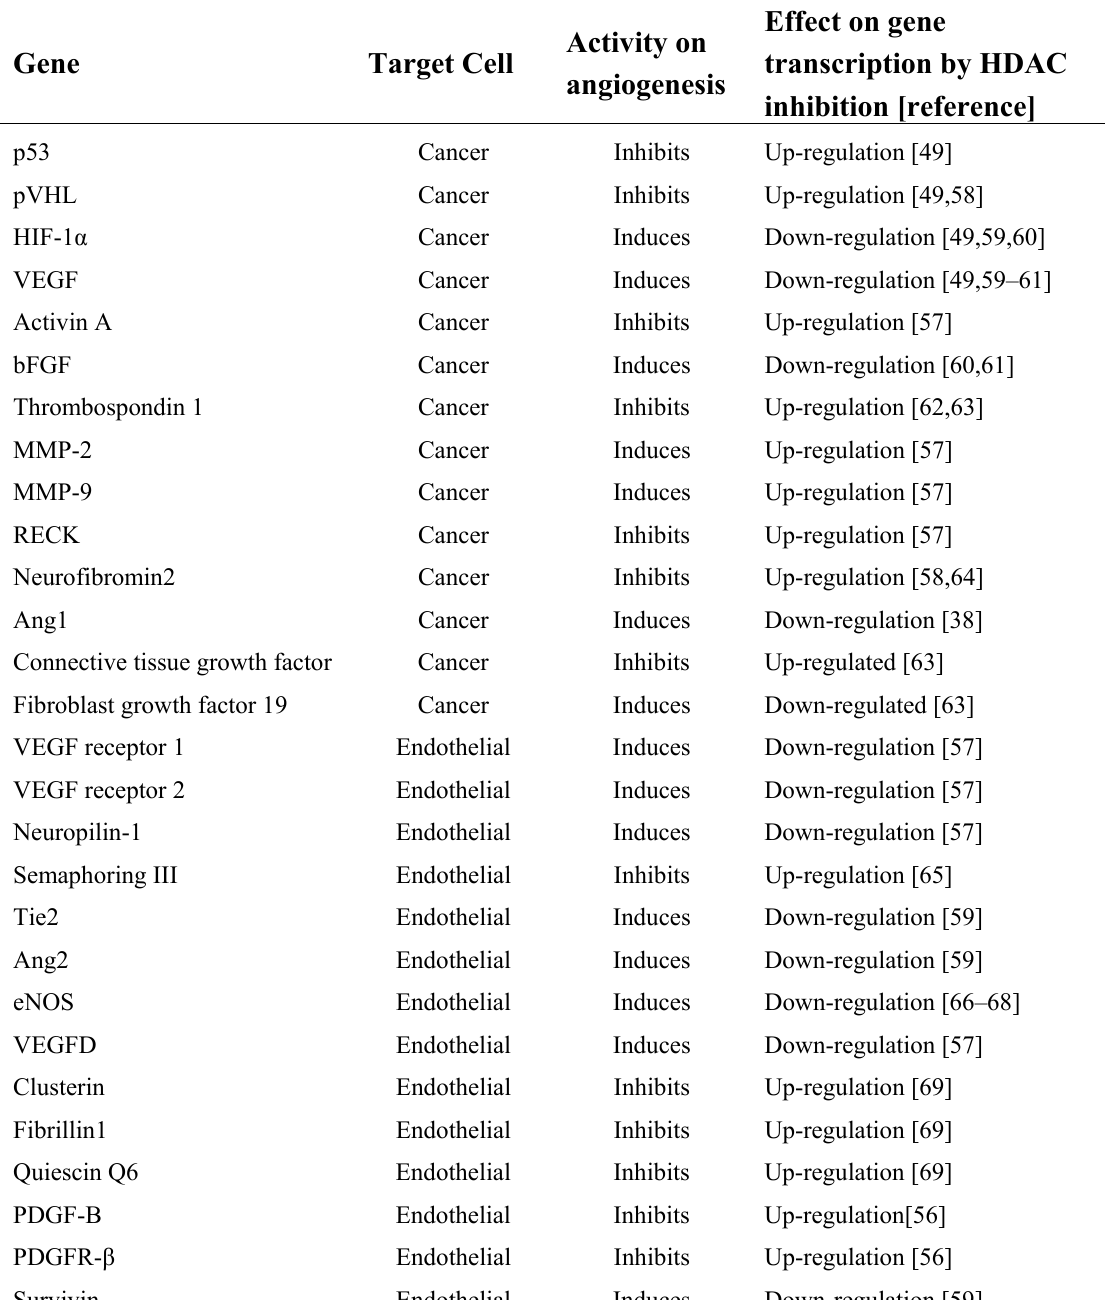
Table 2. Pro- and anti-angiogenic genes altered by HDACI in cancer and endothelial cells. Activity Gene Target Cell